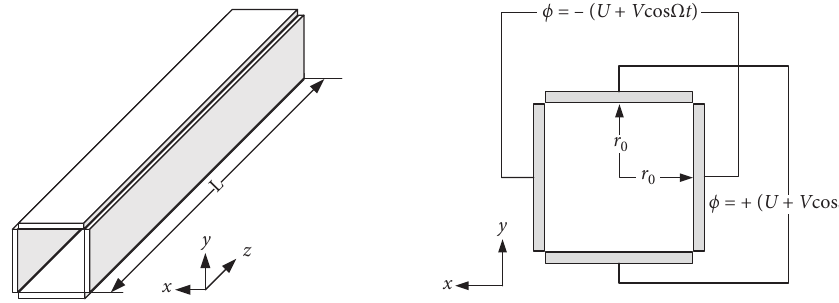
Figure 2: Schematic diagram of the quadrupole mass filter based on rectangular electrodes. Table 1: Simulation parameters for low-vacuum mass